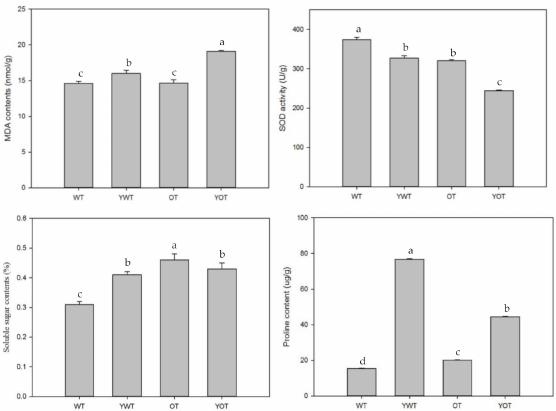
Figure 9. Effect of different treatments on physiological indexes of tobacco: WT, wild-type tobacco; Figure 8. Effects of salt stress on the phenotypes of wild-type and transgenic tobacco. YWT, salt-stressed wild-type tobacco; OT, transgenic tobacco; YOT, salt-stressed transgenic tobacco. Different letters indicate significant differences compared to the control group ( p <